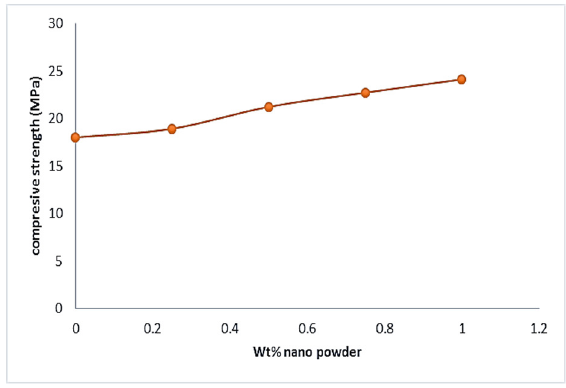
Fig. 3. The Compressive strength of cement